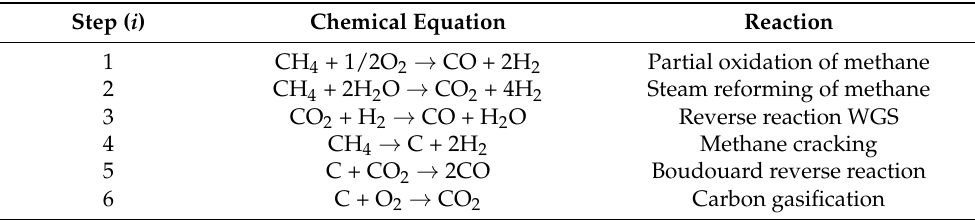
Table 2. Reaction steps of the autothermal reform of methane ATRM [6].